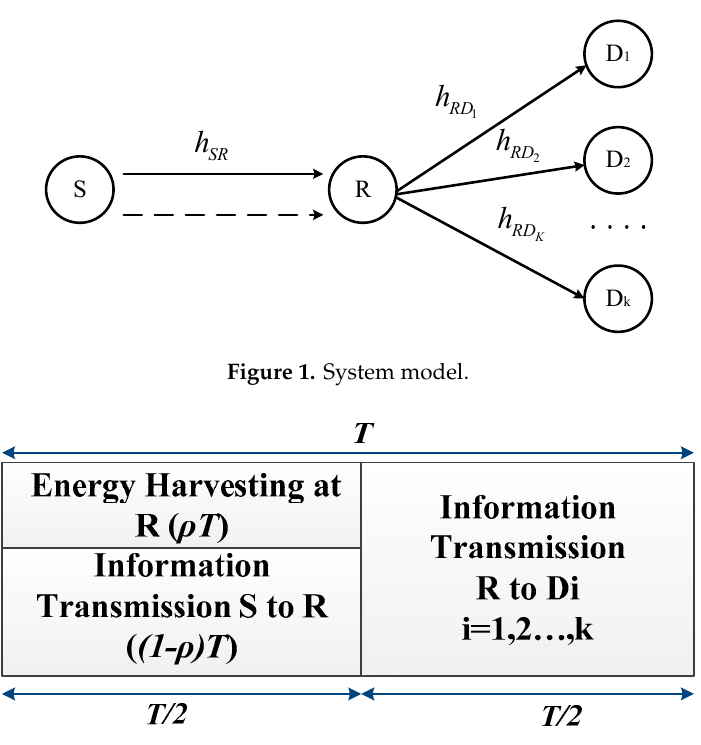
Figure 2. EH and IT of the proposed system.